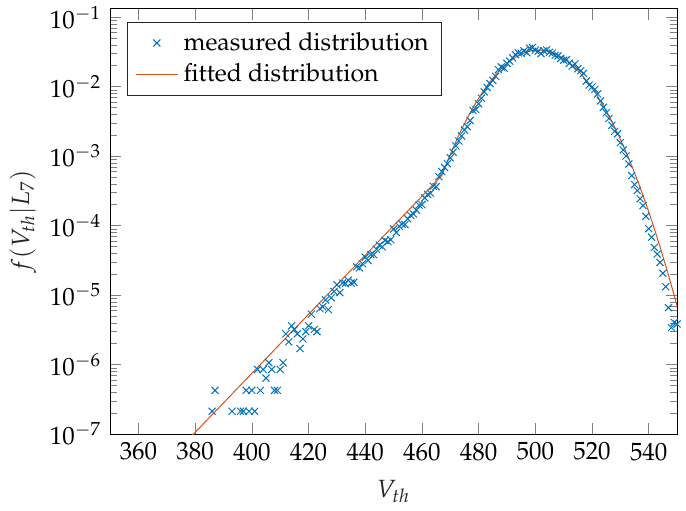
L 7 ) of fresh flash memory. Figure 3. Fitted voltage distribution f ( V th |